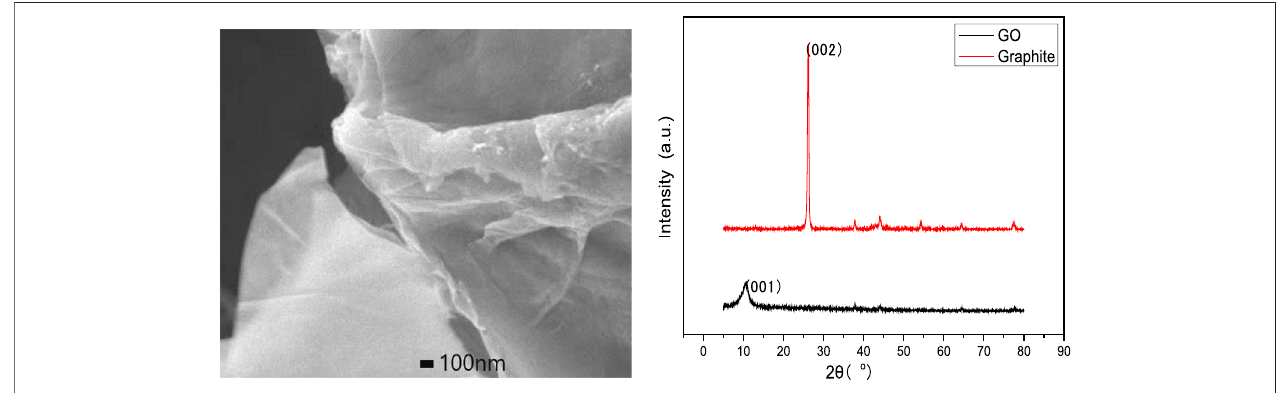
FIGURE 8 | SEM image and XRD patterns of graphene oxide.